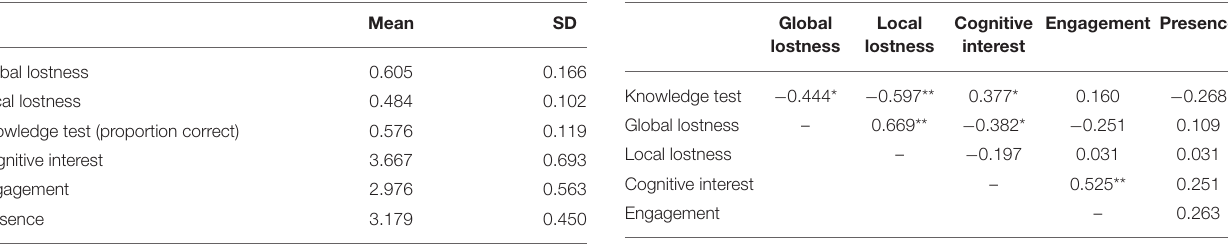
TABLE 6 | Zero-order correlations between knowledge, lostness, and experience measures from the combined